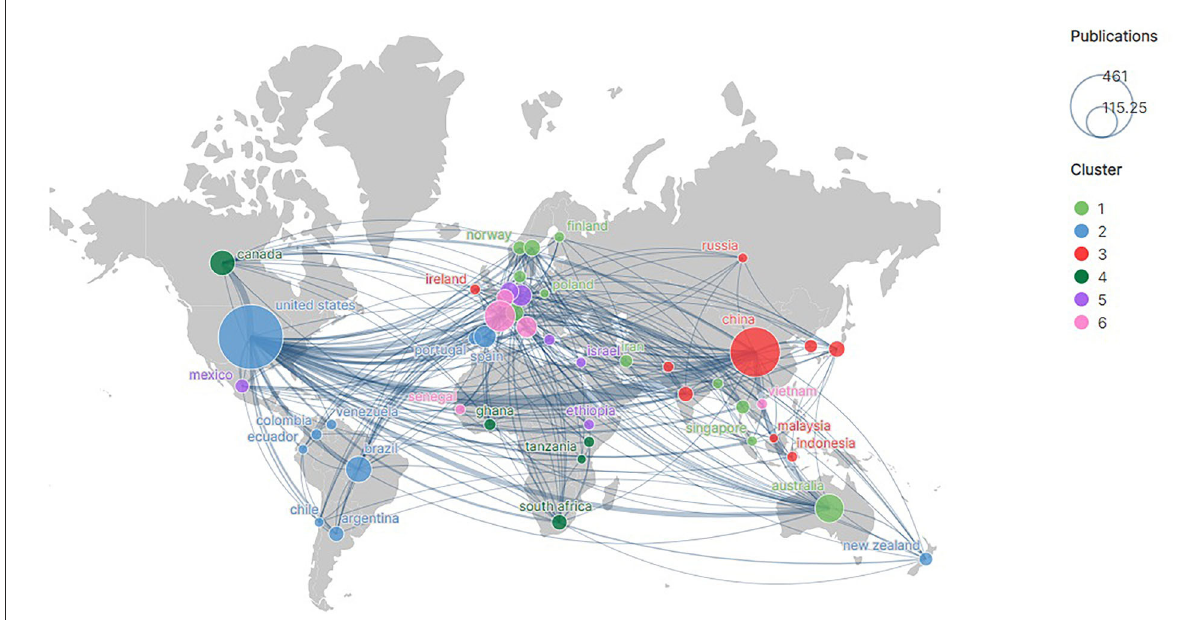
FIGURE4 Country cooperation network. The thicker the line the greater the number of times the two countries work together. The size of the circle means the number of publications in the country.